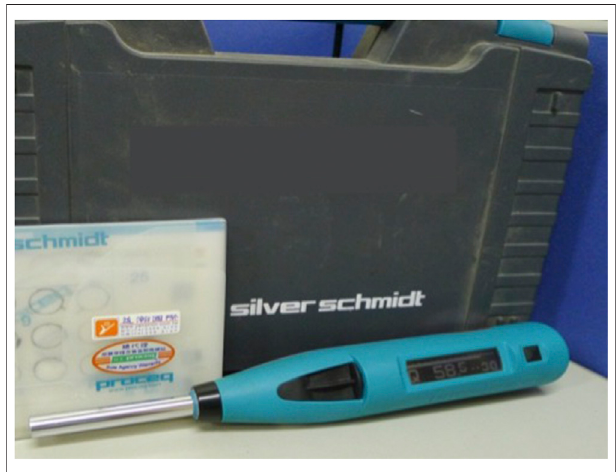
FIGURE 1 | Silver schmidt type N-PC rebound hammer.